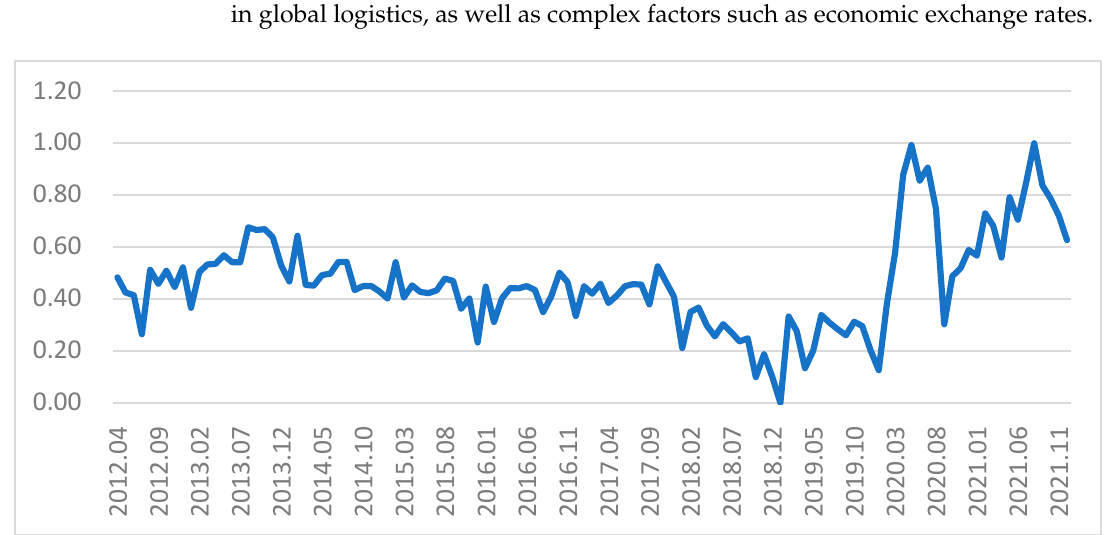
Figure 4. Crisis Index Trend in the Petroleum Refined Products Industry.